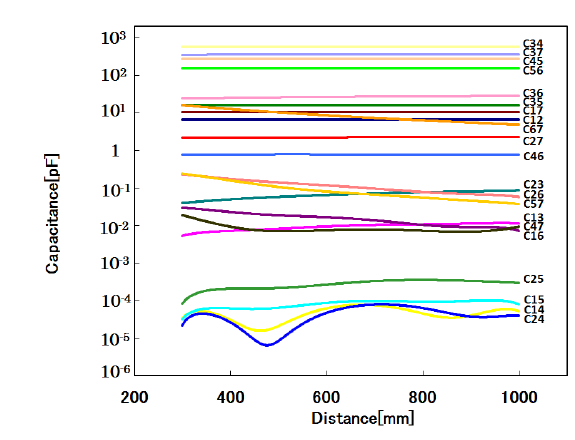
Figure 11. Dependence of capacitance values between seven conductors on the distance between phantom1 and 2.